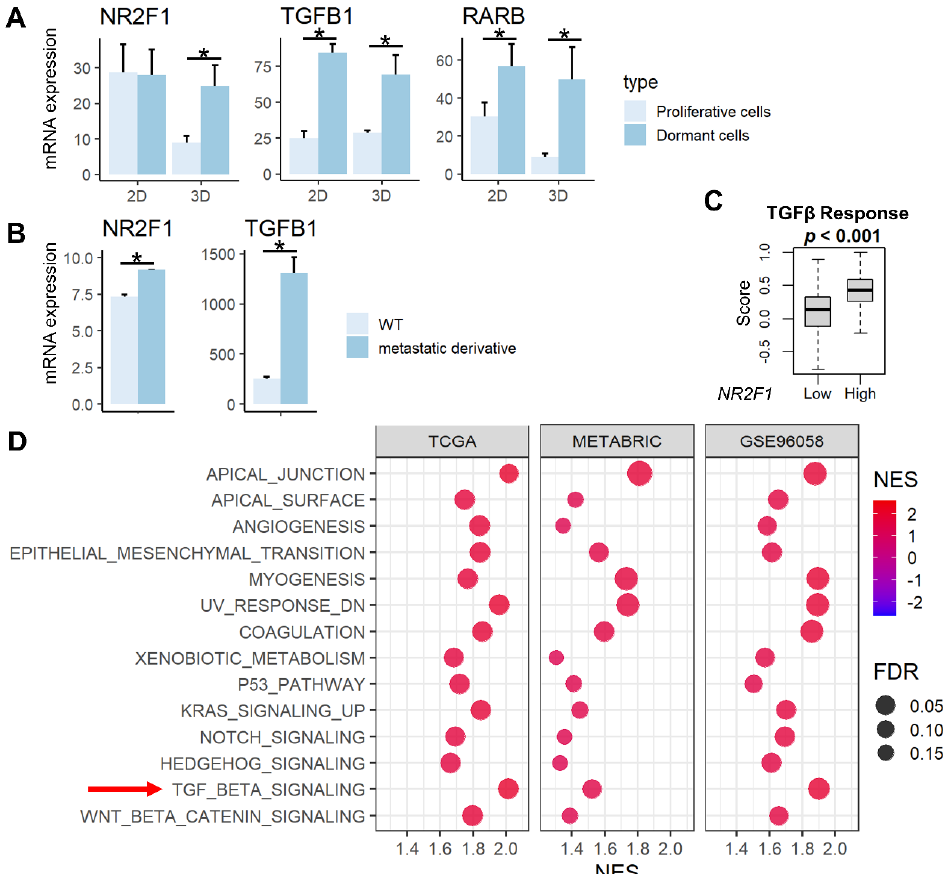
Figure 1. Association between NR2F1 and TGF β and pathways enriched in high NR2F1 tumors. ( A ) Barplots showing mRNA expression of NR2F1 , TGFB1 , and RARB in the dormant D2OR cells (dark blue) and proliferative D2A1 cells (light blue) cultured in 2D and 3D. ( B ) Barplots showing mRNA expression of NR2F1 and TGFB1 in 4T1 murine breast cancer cell line and metastatic derivative 4T1.2 cell line. ANOVA test was performed between the two groups ( A , B ), with * indicating p < 0.05. ( C ) The box plot shows the TGF β score for high and low NR2F1 groups in TCGA. Cohorts were divided into high and low groups by median expression of NR2F1 . Mann − Whitney U test was used to com- pare the two groups. ( D ) Dot plots showing hallmark gene sets that are significantly enriched in high NR2F1 groups by gene set enrichment analysis in the TCGA, METABRIC, and GSE96058 co- horts. TGF β gene set is highlighted by the red arrow. The size of each dot represents FDR, and the x − axis and color tone represent NES. 3.2. Cell Proliferation Was Consistently Suppressed in Breast Cancer with High NR2F1 Expression Given that cell growth arrest is the major characteristic of tumor dormancy, it was of interest to investigate the relationship between NR2F1 expression and cell proliferation. The association of NR2F1 levels with the Nottingham histological grades and the cell pro- liferation marker MKI67 was studied for the pathological assessment of cancer cell prolif- eration. We found that Nottingham grade was inversely related to NR2F1 expression in TCGA and METABRIC, but not in GSE96058 (Figure 2A). MKI67 expression was lower in the NR2F1 high tumor consistently in all three cohorts, and the proliferation score calcu- lated by Thorsson et al. was also lower in TCGA (Figure 2A). Five cell proliferation-related gene sets defined in the Hallmark collection (E2F targets, G2M checkpoint, Myc targets v1 and v2, and Mitotic spindle,) were all strongly suppressed in the high NR2F1 group in all